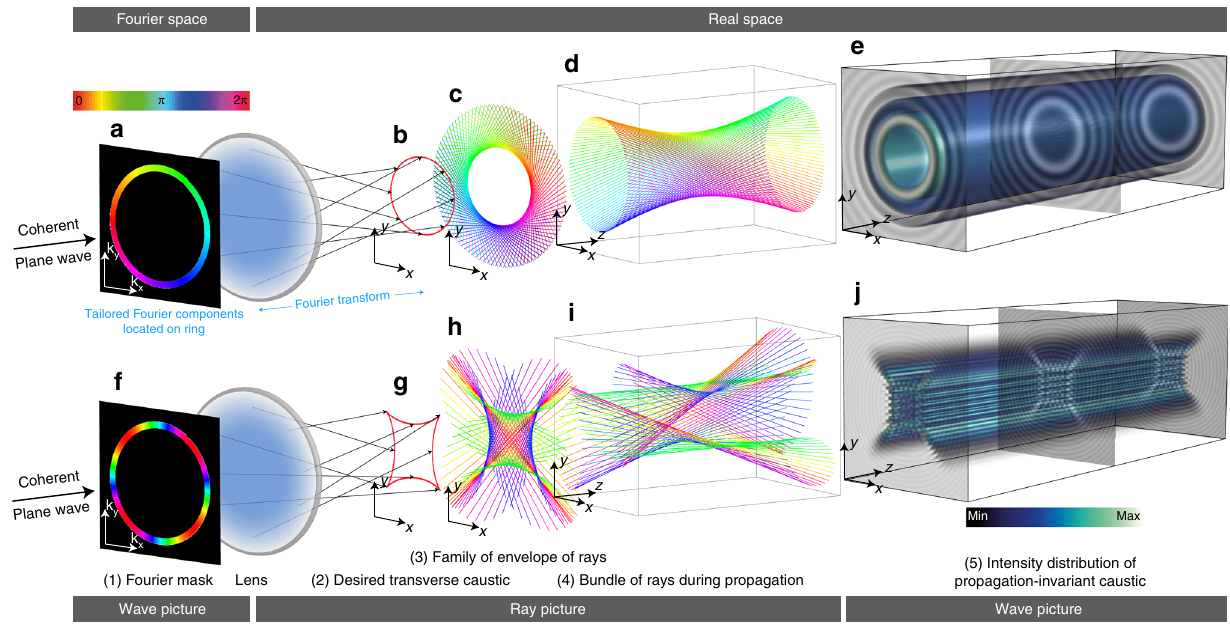
Fig. 1 Caustics in propagation-invariant beams. a – e A Bessel beam J 1 with OAM of charge ℓ = 1 has a circular caustic. a Fourier phase pattern, with azimuthally linearly increasing phase Φ = ℓ ϕ , con fi ned to an in fi nitesimal thin ring. Fourier transform by a lens. Fourier wavefront shaping determines the direction of the propagating rays, and the caustic ( b ) forms in real space as the envelope of the rays in a transverse plane ( c ). A subset of the rays, each coming from a speci fi c point on the ring, is shown in ( d ). The complete family of rays is composed of a continuum of bundles like the one shown in d but displaced in z . The corresponding fi eld has a propagation-invariant transverse intensity ( e ) with a pronounced central ring according to the circular caustic. f – j A more complex phase function Φ ¼ ‘ ϕ (cid:4) q = 2 sin ð 2 ϕ Þ yields an astroid caustic, which includes four cusp